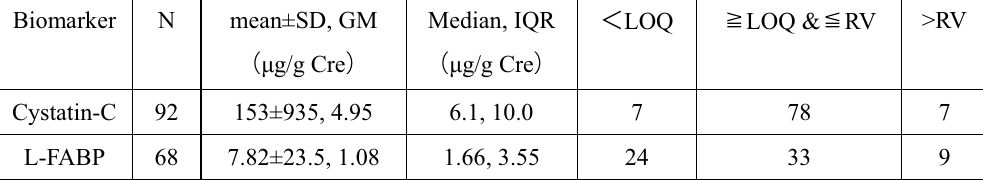
Figure 1. Relationship between L-FABP and Cystatin-C of participants. Black squares stand for CKD patients, small black circles stand for other participants. Broken lines indicate the reference value of markers, L-FABP 8.4 μg/g Cre and Cystatin-C 70 μg/g Cre. Log 10 (L-FABP) = 0.536 × Log 10 (Cystatin-C) + 0.0193, r = 0.75, p <